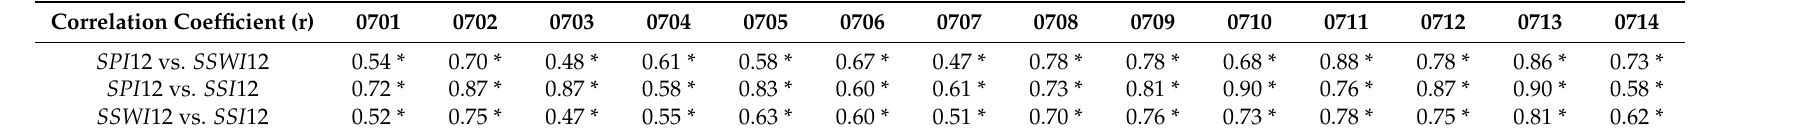
Table 4. Correlation coefficients between SPI , SSWI , and SSI for each subbasins within a 30-year period. Correlation Coefficient (r) SPI 12 vs. SSWI